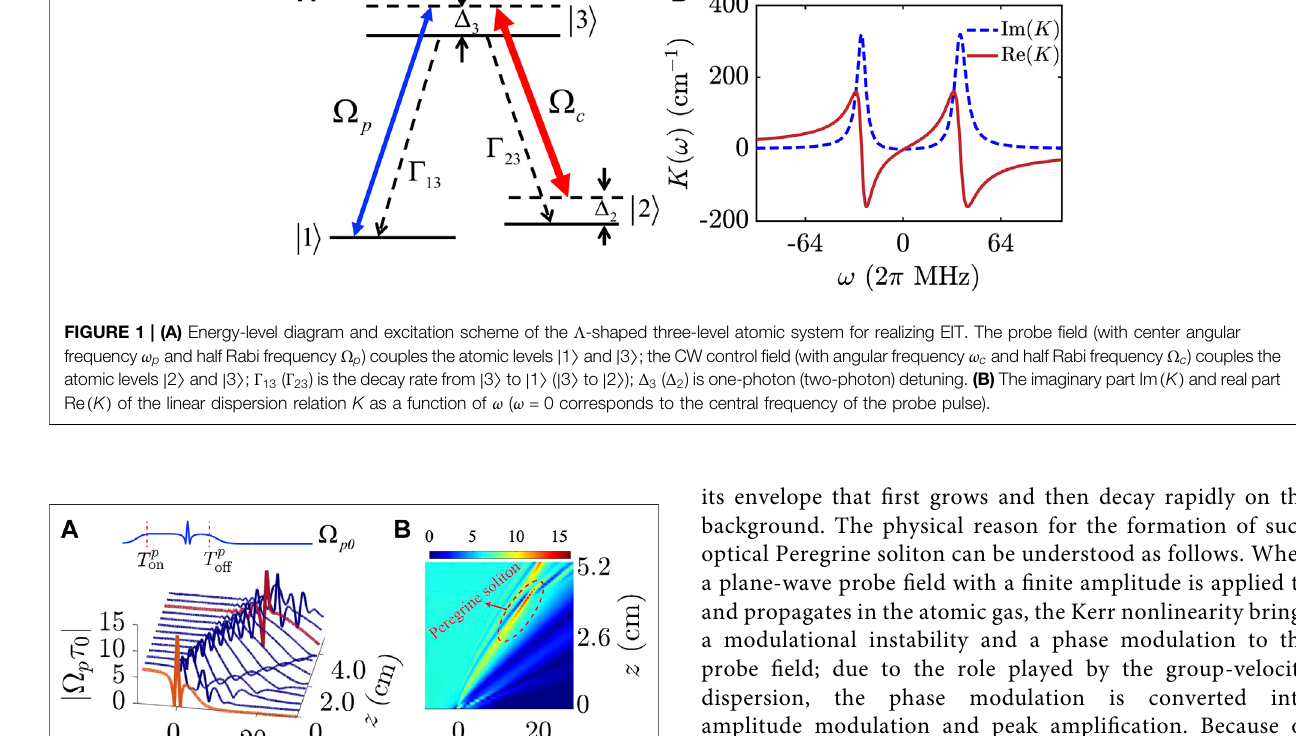
(cid:4)(cid:4)(cid:4)(cid:4) τ | x 15 . 2 Ω p 0 max